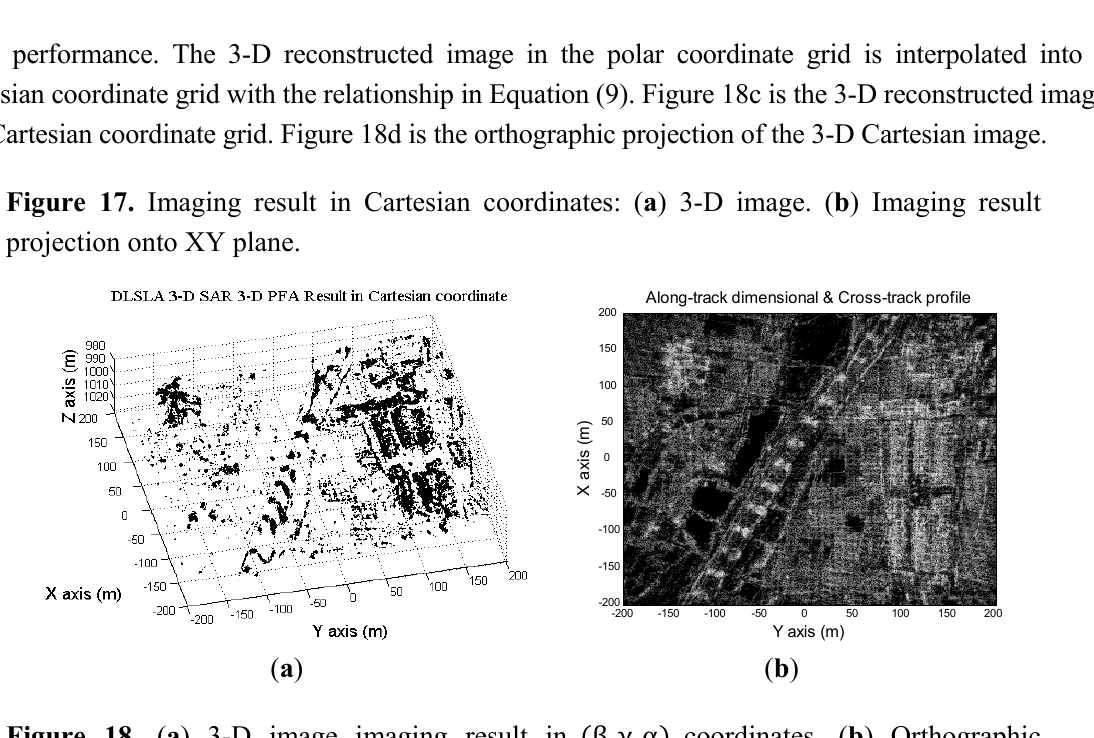
Figure 18. ( a ) 3-D image imaging result in (β, γ, α) coordinates. ( b ) Orthographic projection onto βγ plane. ( c ) 3-D image imaging results in Cartesian coordinates. ( d ) Imaging result projection onto XY